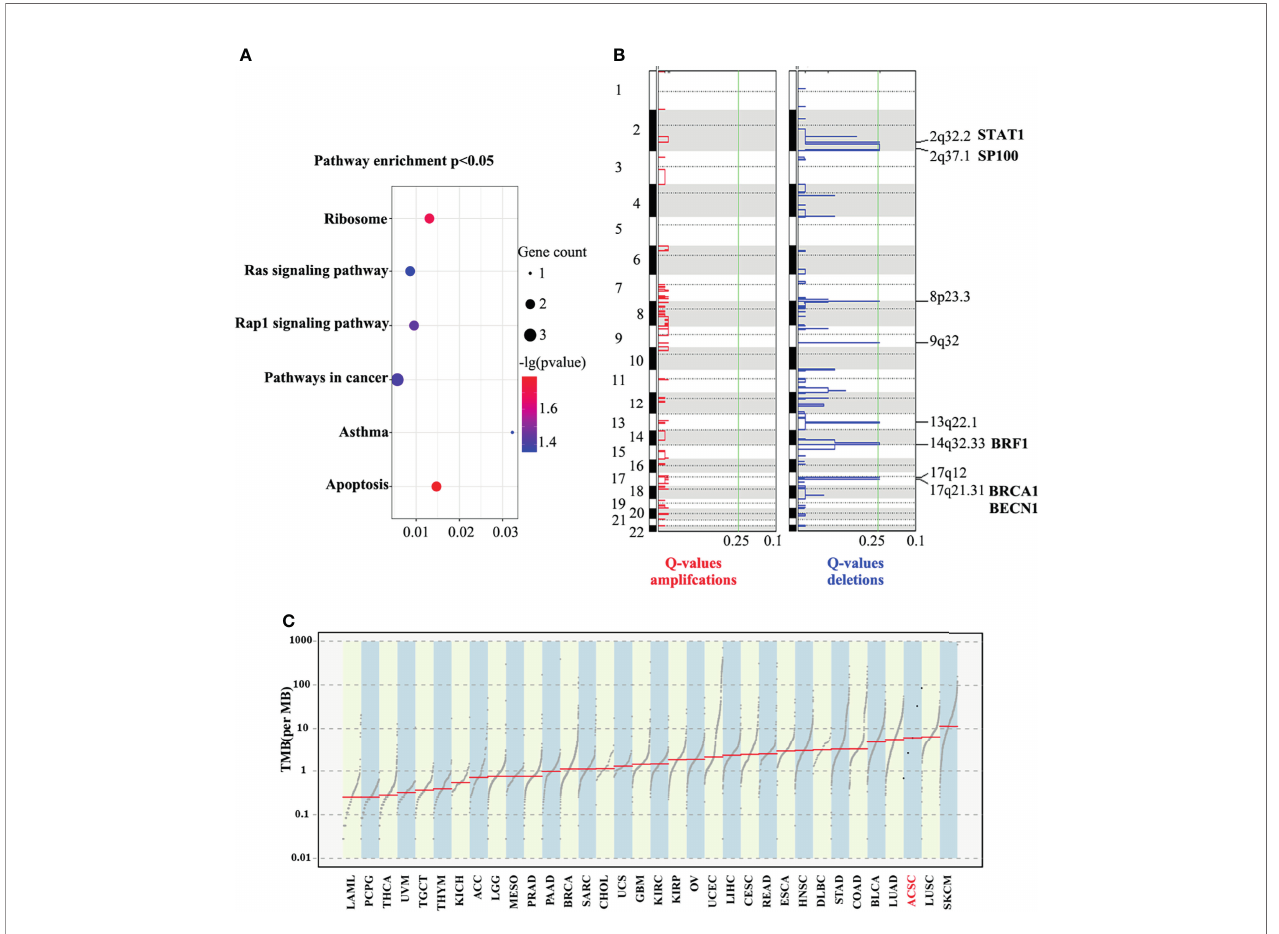
FIGURE 5 | Enrichment in pathway analysis (A) , eight signi fi cantly deleted regions and possible lossed/deleted genes tumor suppressors (B) , and TMB of ACSCC and other malignant tumors (C) . TCGA cancer. LAML, acute myeloid leukemia; PCPG, pheochromocytoma and paraganglioma; THCA, thyroid carcinoma; UVM, uveal melanoma; TGCT, testicular germ cell tumors; KICH, kidney chromophobe; ACC, adrenocortical carcinoma; LGG, brain lower grade glioma; MESO, mesothelioma; PRAD, prostate adenocarcinoma; BRCA, breast invasive carcinoma; SARC, sarcoma; CHOL, cholangiocarcinoma; UCS, uterine carcinosarcoma; GBM, glioblastoma multiforme; KIRC, kidney renal clear cell carcinoma; OV, ovarian serous cystadenocarcinoma; UCEC, uterine corpus endometrial carcinoma; LIHC, liver hepatocellular carcinoma; CESC, cervical squamous cell carcinoma and endocervical adenocarcinoma; READ, rectum adenocarcinoma; ESCA, esophageal carcinoma; HNSC, head and neck squamous cell carcinoma; DLBC, lymphoid neoplasm diffuse large b-cell lymphoma; STAD, stomach adenocarcinoma; COAD, colon adenocarcinoma; BLCA, bladder urothelial carcinoma; LUAD, lung adenocarcinoma; LUSC, lung squamous cell carcinoma; SKCM, skin cutaneous